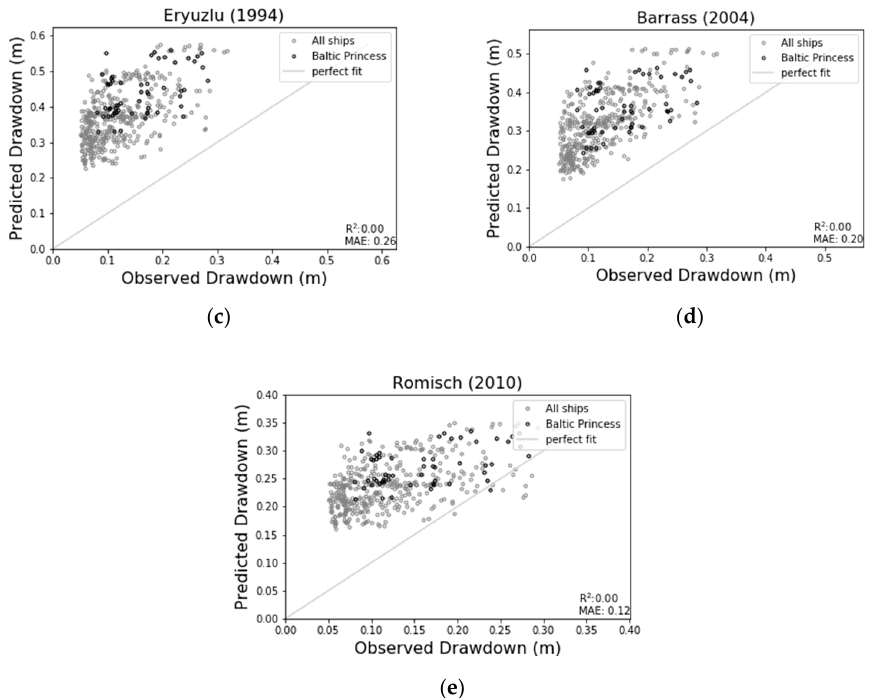
Figure 9. Calculated squat with empirical equations versus measured drawdown height at Nykvarnsholme and Björnhuvud for the existing empirical equations for squat of Huuska [29] ( a ); Yoshimura [34] ( b ); Eryuzlu [36] ( c ); Barrass [32] ( d ); and Römisch [35] ( e ). Grey markers represent all ships, whereas black markers only show data for the ship Baltic Princess. The drawdown from a single ship is included to show that the scatter is not related to the lack of information about the ship hull coefficient. The grey line displays the perfect fit between measured and predicted drawdown.